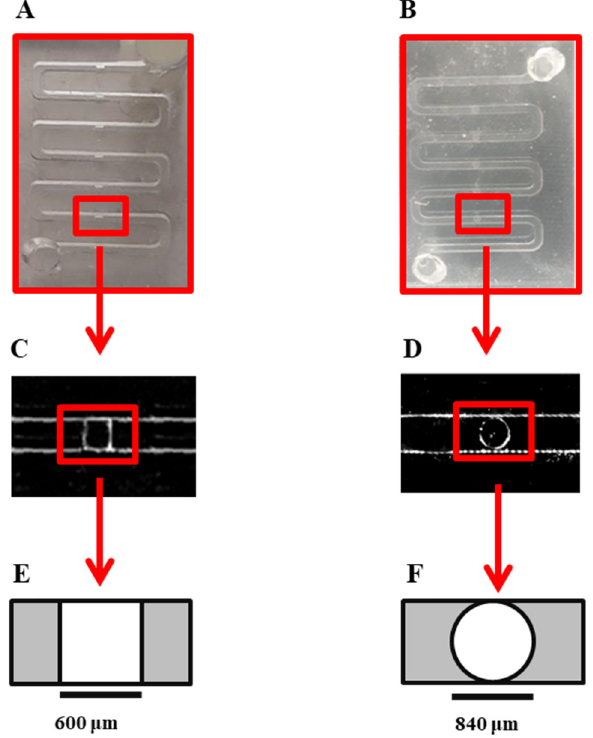
Figure 1. Microscopic image and schematic of the cube-shaped cell-trapping microwell: ( A ) Image of the channel in previous design with cube-shaped cell-trapping chamber. Each channel has a length of 78 mm with a cross-section of 600 μm × 600 μm with five cube-shaped cell-trapping chambers for cell sedimentation and spheroid formation. ( B ) Image of the modified design used in this work with cylindrical-shaped cell-trapping chambers. Each channel has a length of 109.2 mm with a cross-section of 840 μm × 840 μm with five cylindrical cell-trapping chambers for cell sedimentation and spheroid formation ( C ) Top view of microscopic image of cell-trapping chamber of the previous design; the size of the chamber is 600 μm × 600 μm and the height of the chamber is 540 μm. ( D ) Top view microscopic image of modified cylindrical-shaped cell-trapping chamber in the present study; the radius of the chamber is 840 μm and the height of the chamber is 756 μm. ( E ) Schematic top view of cube-shaped cell-trapping chamber in previous design. ( F ) Schematic top view of cylindrical-shaped cell-trapping chamber in the current design used in this work.